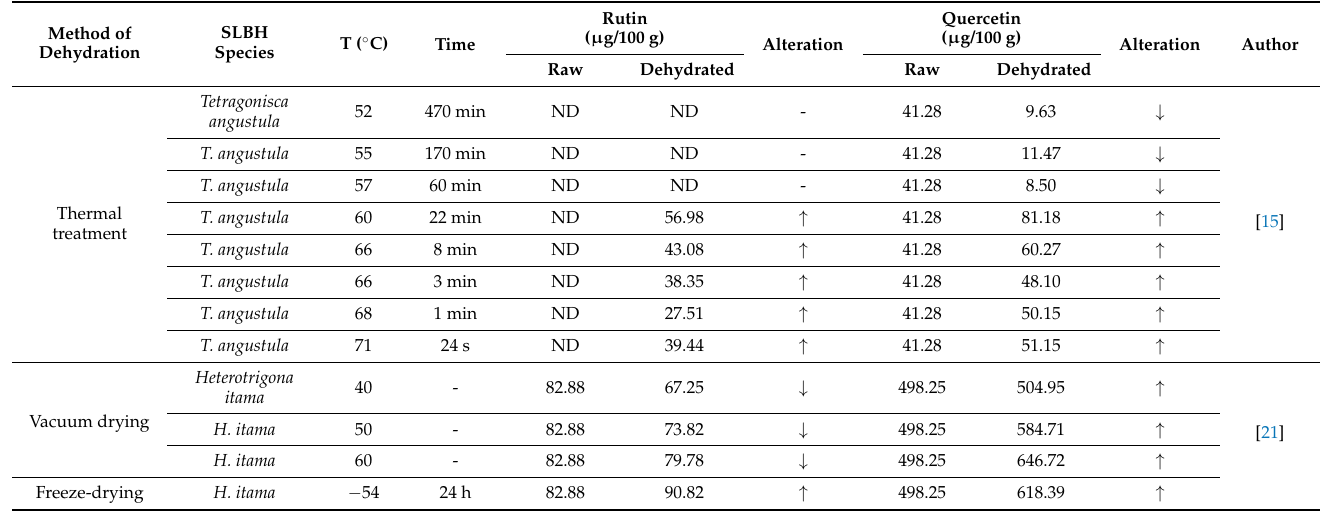
Table 14. Individual phenolic compounds of raw and dehydrated stingless bee honey (SLBH).